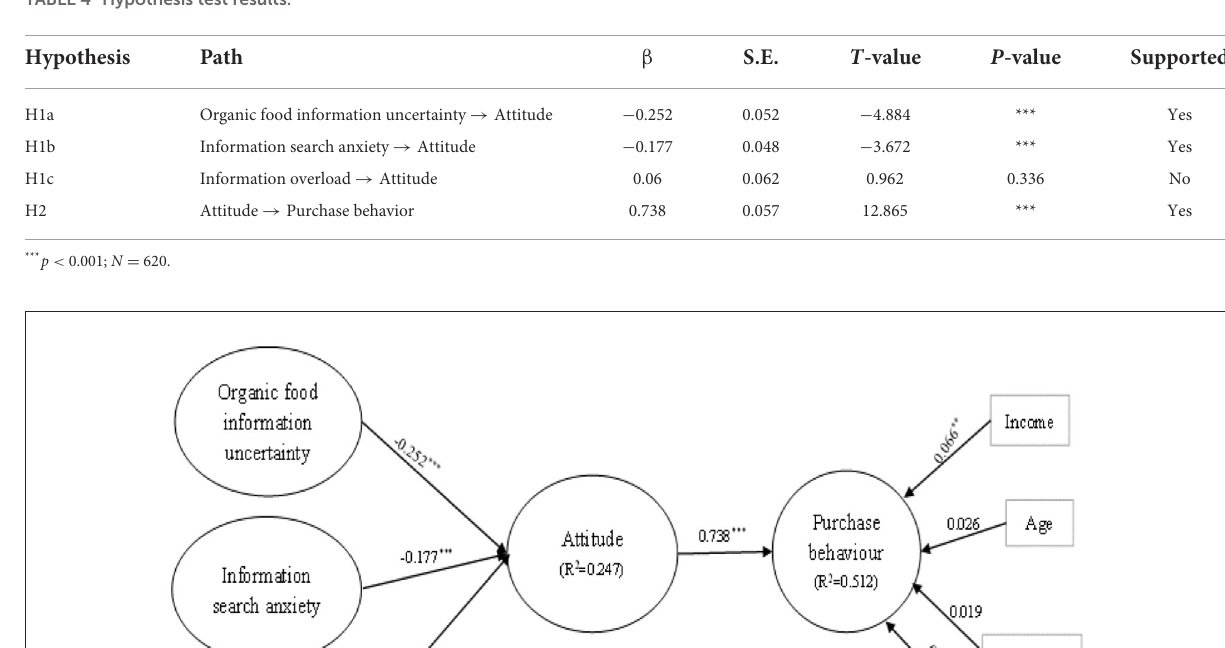
TABLE 4 Hypothesis test results.